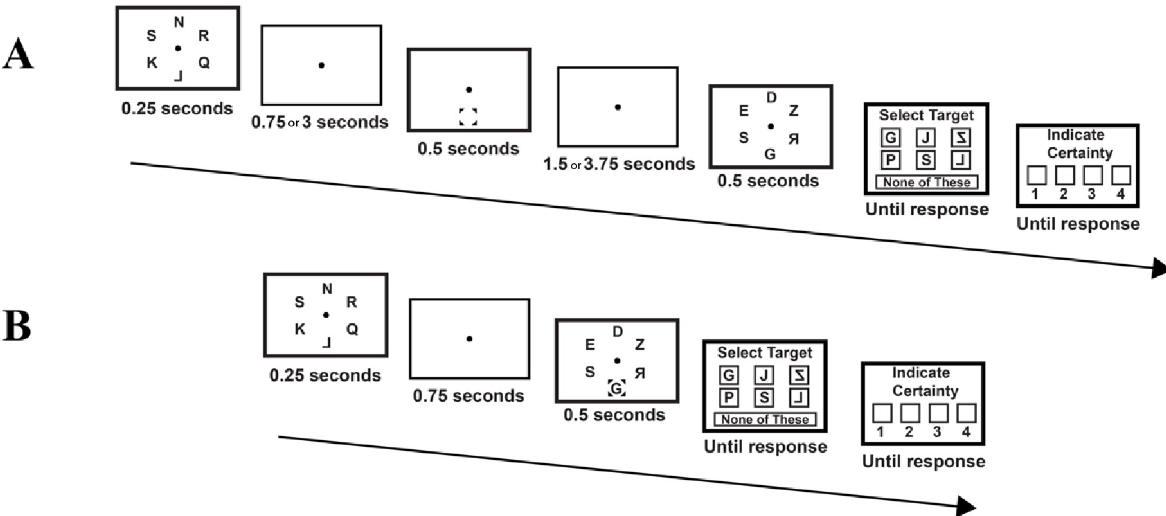
Fig 1. Experiment 1—Procedure. The memory display consisted of 6 or 8 letters. It contained 1 to 2 pseudo letters (set size 6) or 2 pseudo letters (set size 8). In all 3 memory delay conditions the trial started with the memory display appearing for 0.25 seconds. Subsequently in the Short and Long conditions (panel A) the memory cue appeared after a blank of 0.75 seconds (Short) or 3 seconds (Long), for 0.5 seconds, on a blank screen. Subsequently, 5 seconds after offset of the memory display, an irrelevant second letter display, containing the same amount of (randomly selected) real and pseudo-letters as the memory display, appeared for 0.5 seconds. The Short with Interference condition (panel B) was the same as the Short condition, except that now the second letter display appeared together with the cue. In all conditions, after offset of the second letter display, the participant first indicated the identity of the letter at the cued location in the memory display. Subsequently she indicated confidence in her judgment (1 = guess, 4 = certainty).